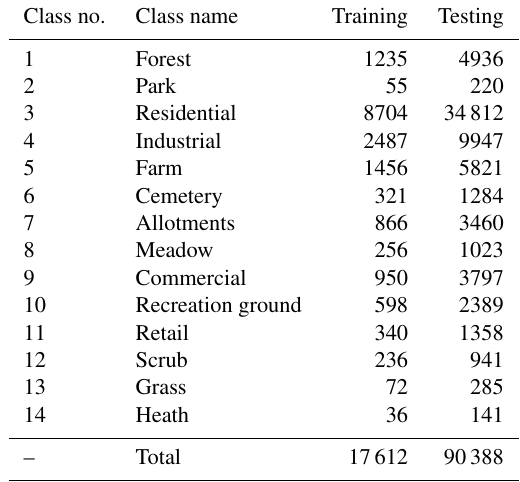
Table 7. This table lists category information of the investigated